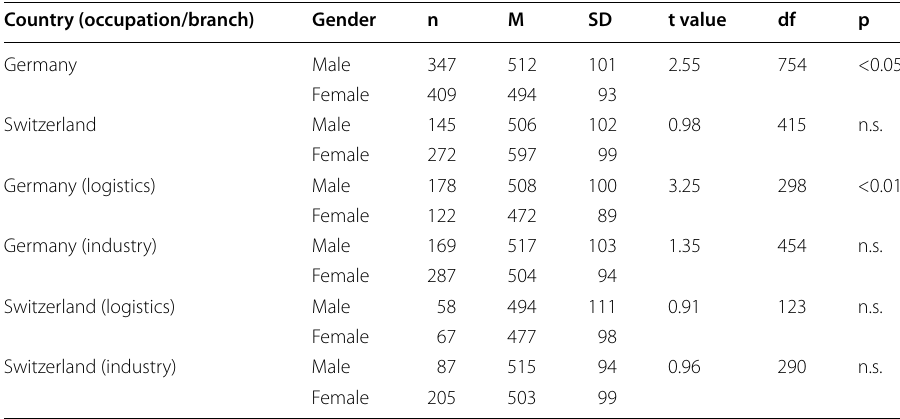
Table 3 Country-specific competence scores by commercial occupation and gender Country